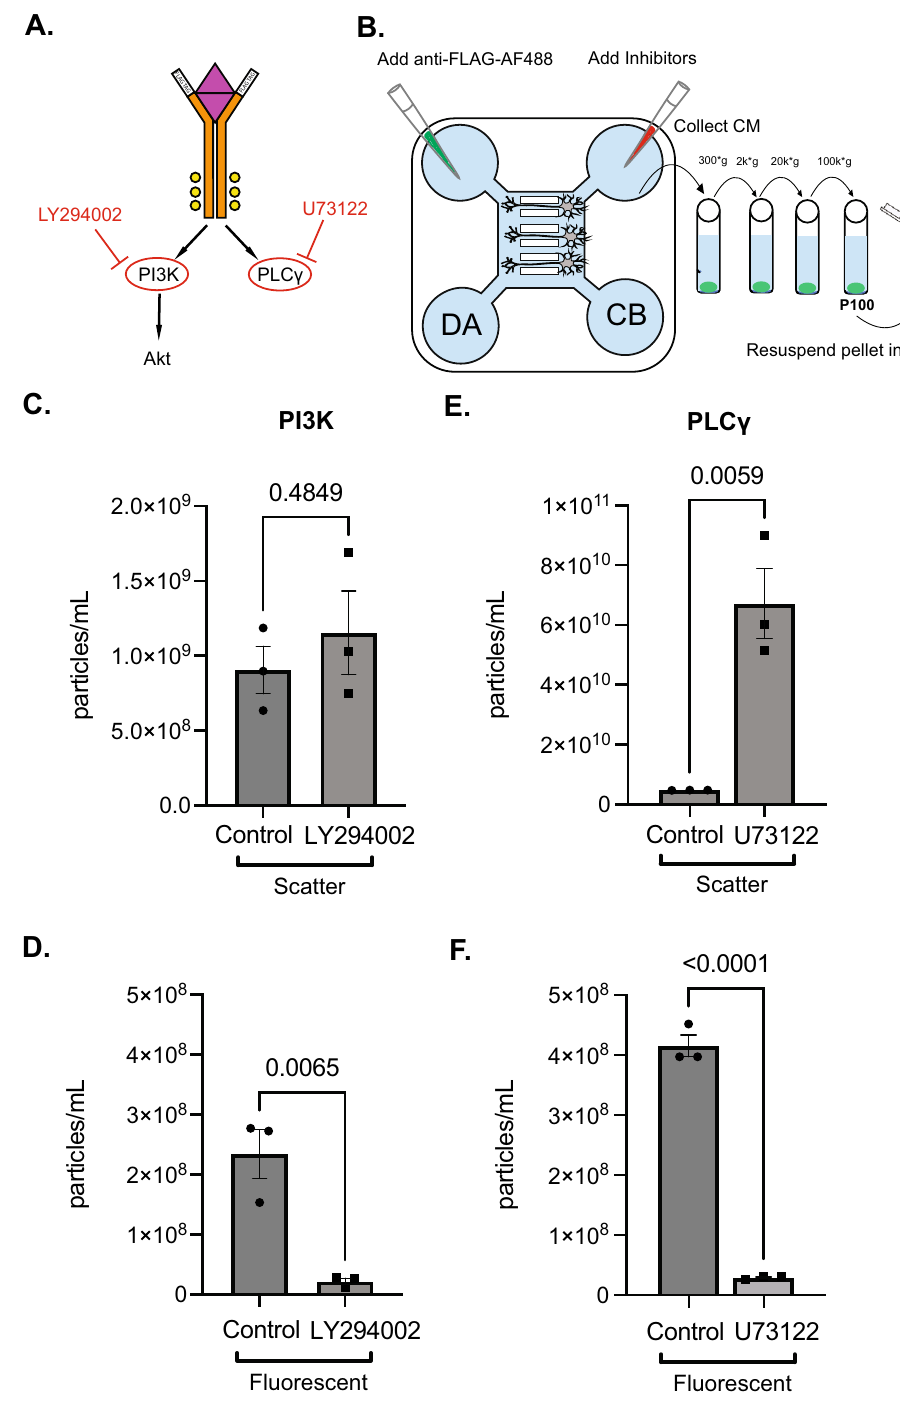
Figure 5. Inhibition of TrkA-dependent signaling pathways suppresses TrkA + EV release. ( A ) Schematic of the downstream pathways activated by TrkA phosphorylation and inhibitors that block them. ( B ) Schematic of inhibitor and Anti-FLAG-AF488 antibody application to compartmentalized neurons to generate TrkA + EVs. ( C ) , ( D ) Quantification of the total number of scatter or fluorescent (Anti-FLAG-AF488 + ) particles detected after anti-FLAG-AF488 antibody addition to the DA chamber of MFDs containing TrkA FLAG/FLAG SCG neurons treated with the PI3K inhibitor, LY294002. ( E ) , (F ) Quantification of the total number of scatter or fluorescent (Anti-FLAG-AF488 + ) particles detected after anti-FLAG-AF488 antibody addition to the DA chamber of MFDs containing TrkA FLAG/FLAG SCG neurons treated with the PLC- ɣ inhibitor, U73122. Shown is the mean ± SEM for three biological replicates. P values are indicated above the pairwise